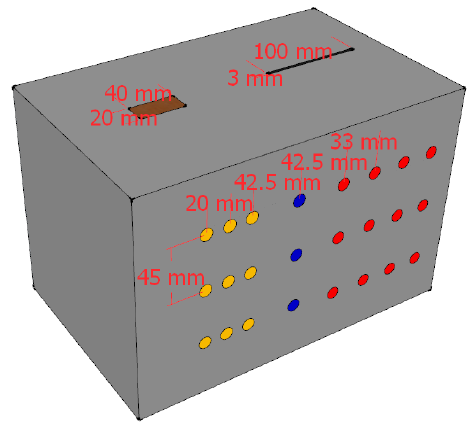
Figure 7. Block I detection position.